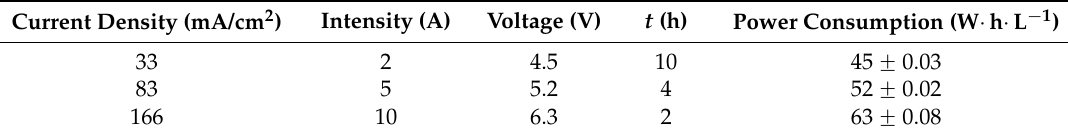
Table 2. Electrochemical degradation of CY and power consumption at three current